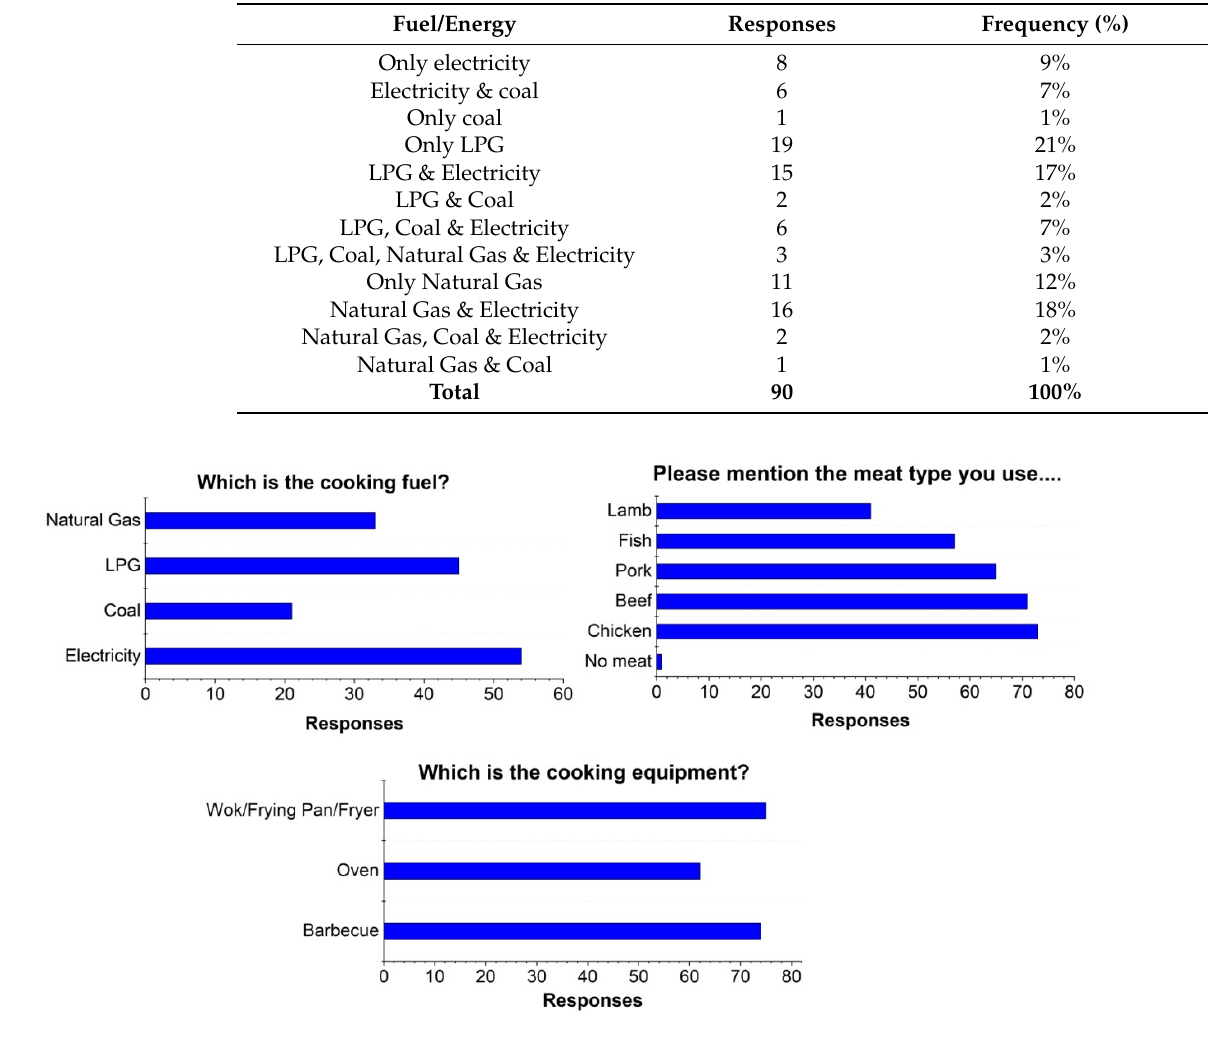
Figure 3. Survey responses concerning the type of fuel, meat and equipment used. Table 4. Equipment type using natural gas, coal, LPG and electricity.